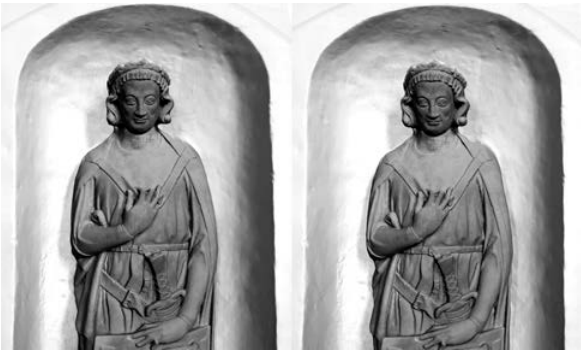
Figure 6: Stereoscopic image pair